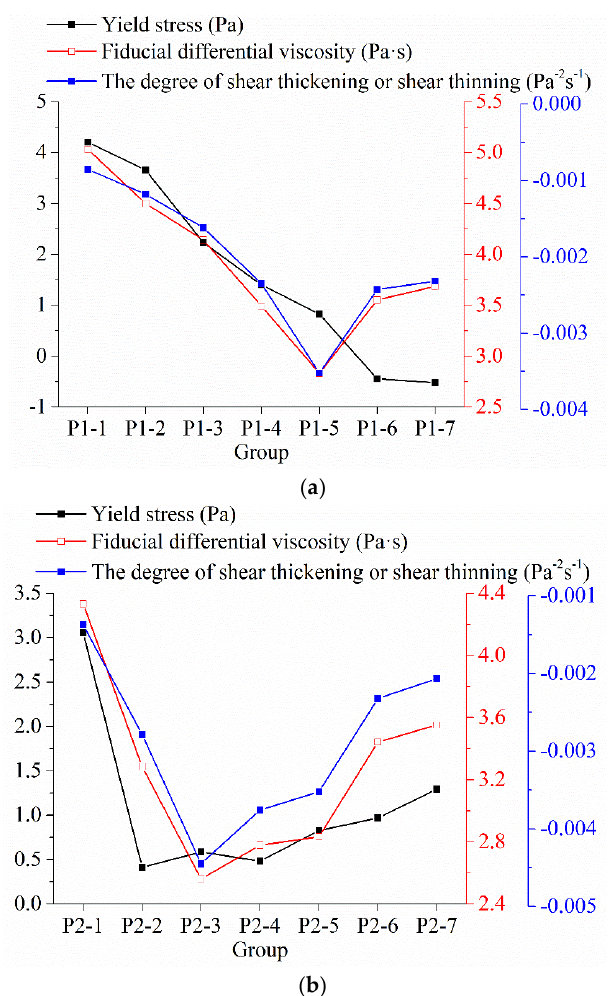
Figure 8. Rheological parameters calculated based on parabolic model. ( a ) P1; ( b ) P2.